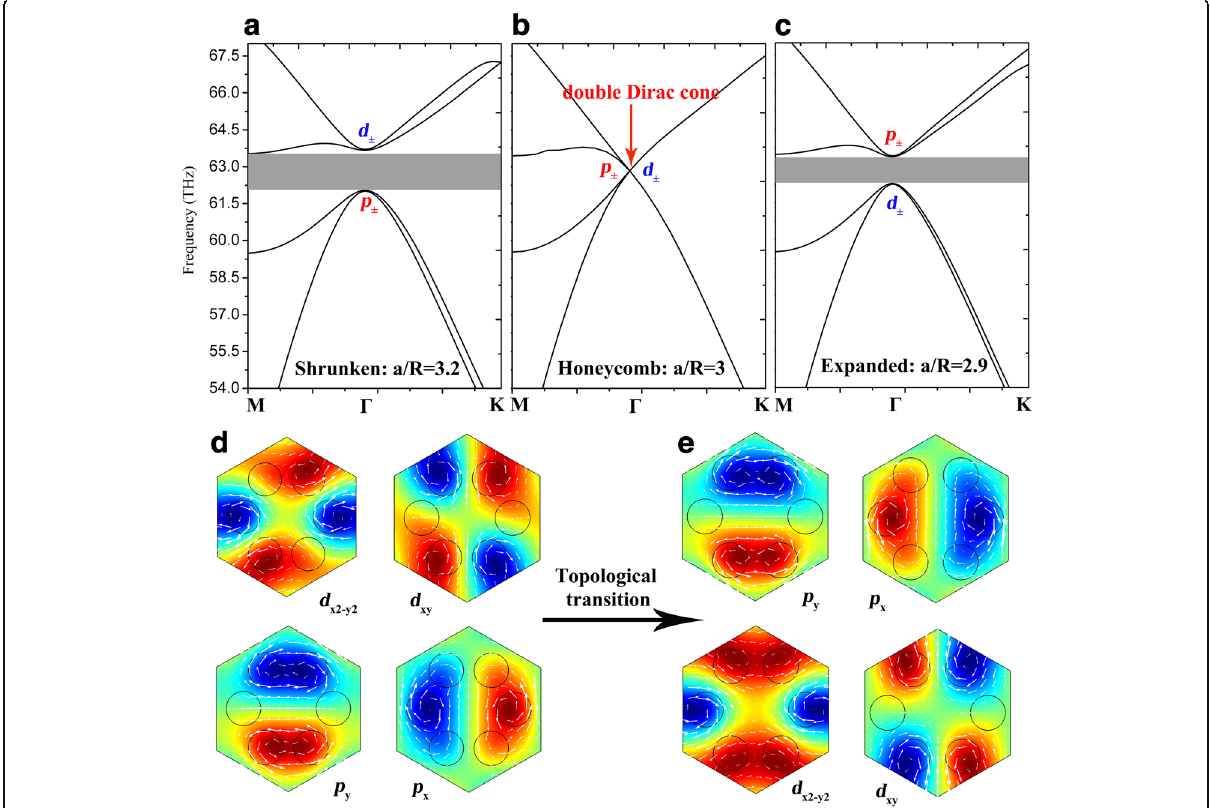
Fig. 2 Band structures of the GPCs with a a / R = 3.2, b a / R = 3, and c a / R = 2.9. d , e The E z field distributions of dipole modes and quadrupole modes of the p ± and d ± states in a and c respectively. The white arrows present the in-plane magnetic field associated with E z